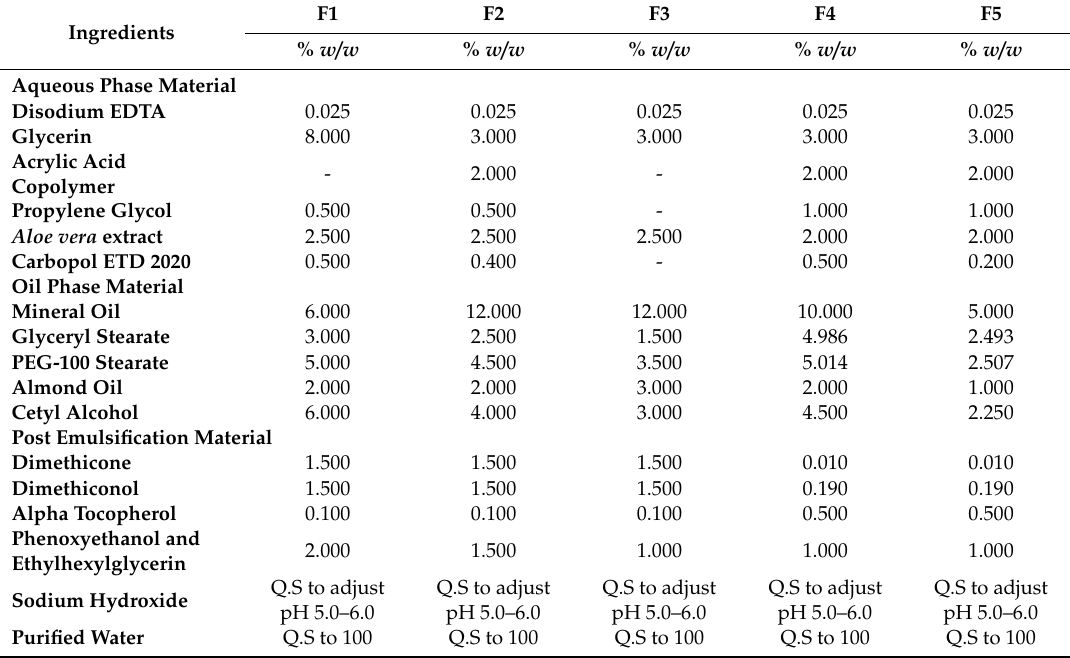
Table 1. Percentage composition of di ff erent formulations of moisturizing cream